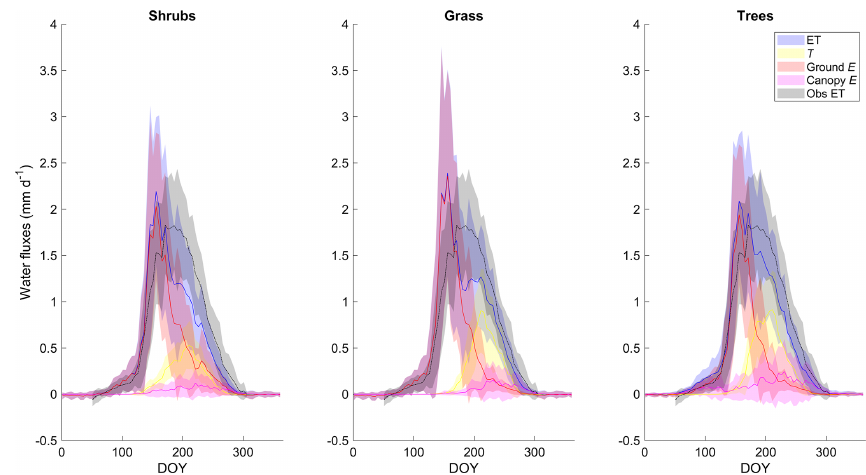
Figure 5. Mean 5d average modelled evapotranspiration (ET) and its component fluxes (transpiration ( T ), ground and canopy evaporation ( E )) along with observed ET averaged over 2004–2017 for the shrub, grass, and tree PFT simulations using the new β (Merlin et al., 2011) formulation. Shaded areas show the standard deviation of the daily mean for 2004–2017. Table 5. Mean ± SD annual and growing season (GS; 1 May–30 September) net ecosystem productivity (NEP), gross primary productivity (GPP), and ecosystem respiration ( R e ) averaged over 2004–2017 for the shrub simulations using the new (Merlin et al., 2011) and origi- nal β (Lee and Pielke, 1992) formulation, for the grass and tree simulations, and for observations. Eddy covariance flux measurements were not available through the winter and are only reported for the growing season. Standard deviations (SDs) for the observed and simulated fluxes are calculated by error propagation of the SD of daily values.